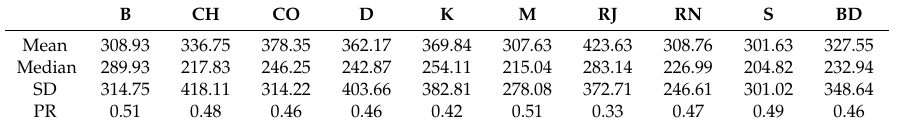
Table 2. Mean, median and standard deviation of per-capita income (US$/yr), by region. B CH CO D K M RJ RN S BD Mean